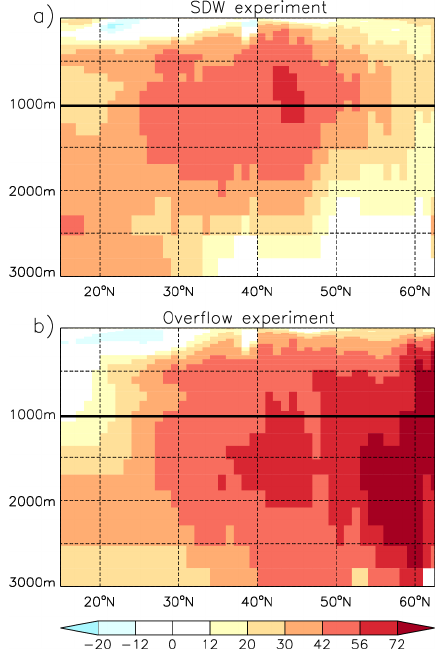
Fig. 9. Change (in %, for definition see text) in the standard de- viation of the bandpass-filtered (15–80 years) Atlantic meridional overturning streamfunction in (a) the SDW experiment and (b) the overflow experiment compared to the control simulation with MPI- ESM-CR. Note that positive (negative) values correspond to a re- duction (increase) in the standard deviation in the sensitivity exper- iments. The colour scale is chosen to match the explained variance, i.e. (correlation coefficient) 2 , in Figs. 3–5. The depth level presented in Figs. 3–5 is indicated by the solid